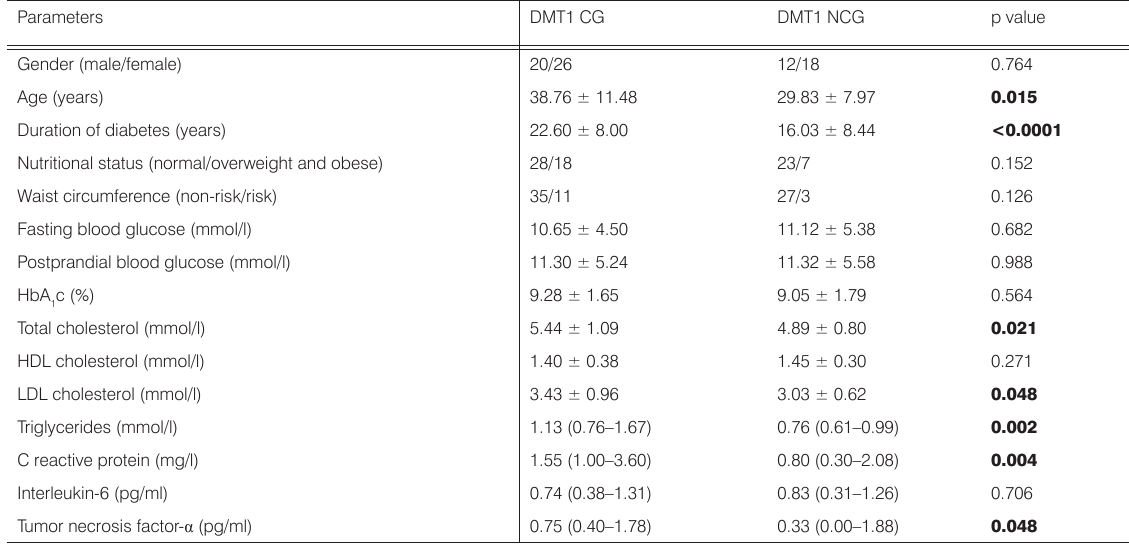
Table 1. General, anthropometric, glucose metabolism, lipid and lipoprotein parameters and infl ammatory cytokine levels in DMT1 patients with at least one of the microvascular complications and DMT1 patients without chronic microvascular complications Parameters